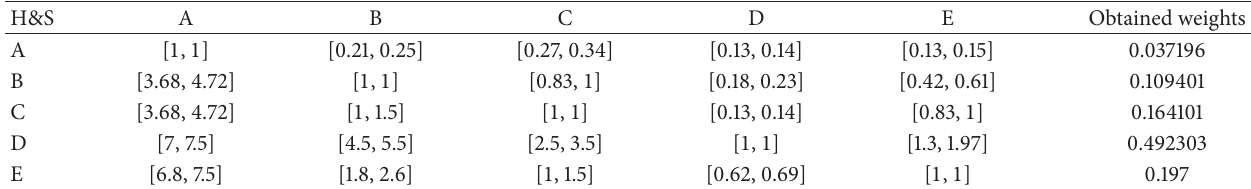
Table 16: The interval approximation choices referring to H&S subcriteria.